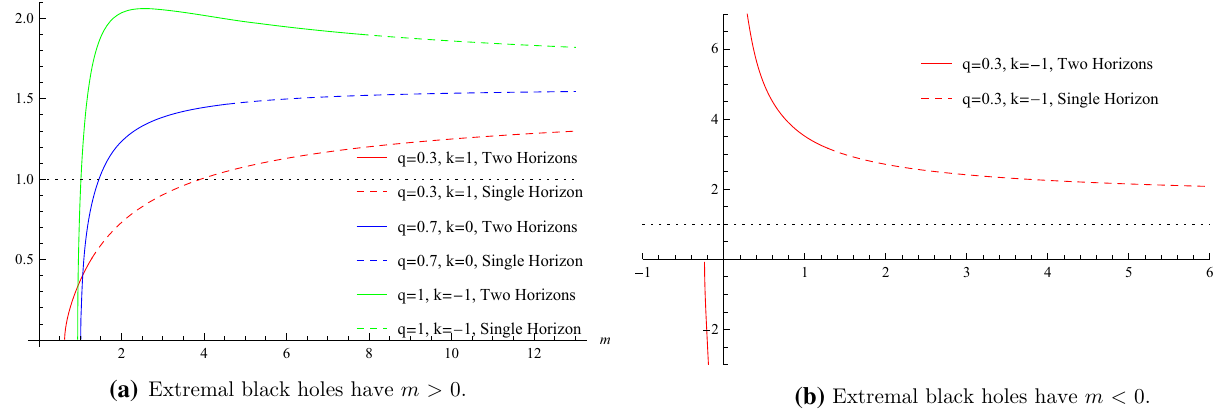
Fig. 6 The rate of the complexity in CV duality divided by the Lloyd bound, ˜ R V . Here we take d = 3, L = 1 and β = 10